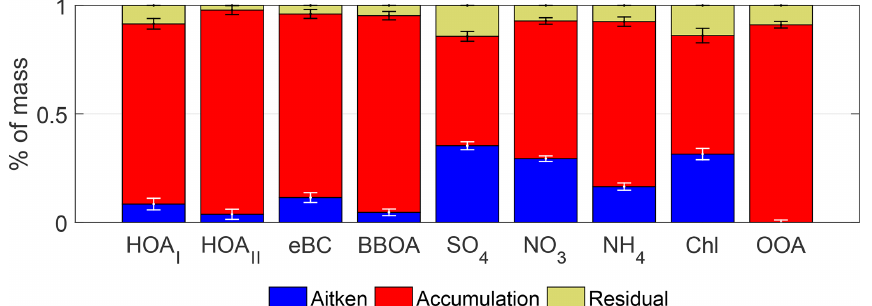
Figure 7. Contributions of aerosols size modes into mass concentrations for PM 1 chemical species and confidence intervals. Results from the MLR model.